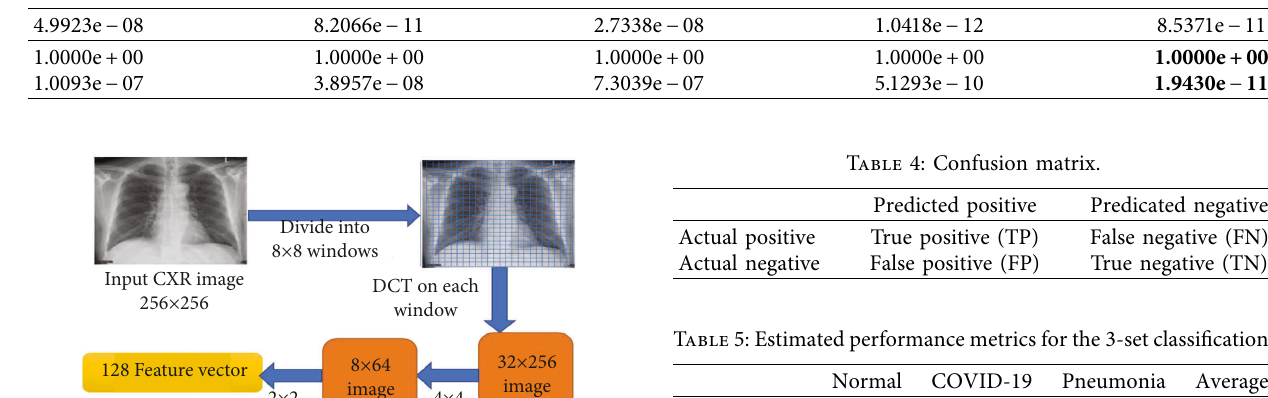
Table 3: Outputs for tested true positive COVID-19 CXR cases.